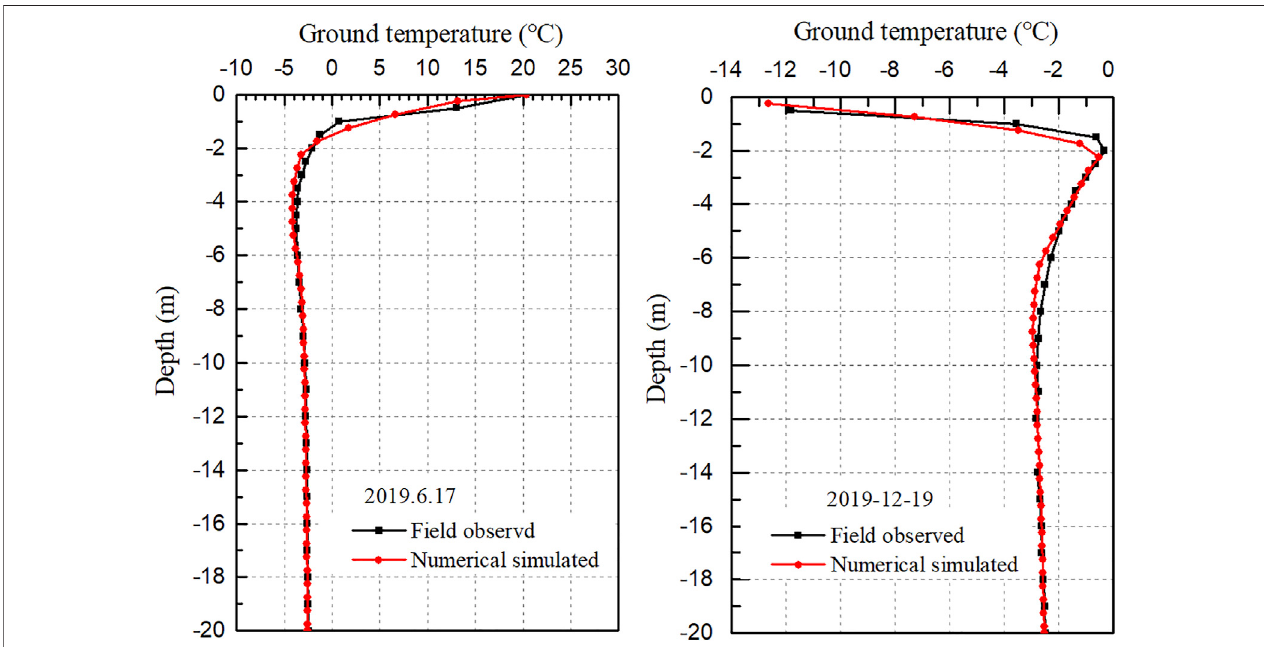
FIGURE 5 | Comparison between fi eld observation data and numerical simulation results for ground temperatures in Borehole T1 at the undisturbed area in the Gulianhe strip coalmine in the Hola Basin in northern Da Xing ’ anling Mountains, Northeast China.